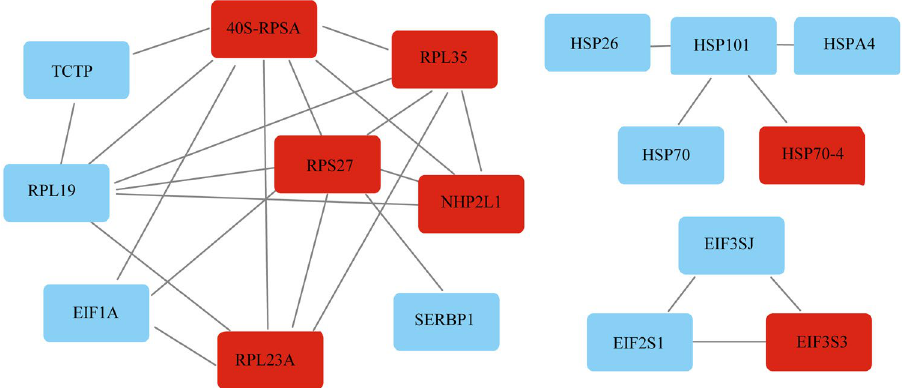
Figure 6. Protein-protein interaction analysis of DEPs. A total of 17 proteins were involved in protein-protein interactions that contained 3 main clusters with 7 up-regulated (marked with red blocks) and 10 down- regulated proteins (blue